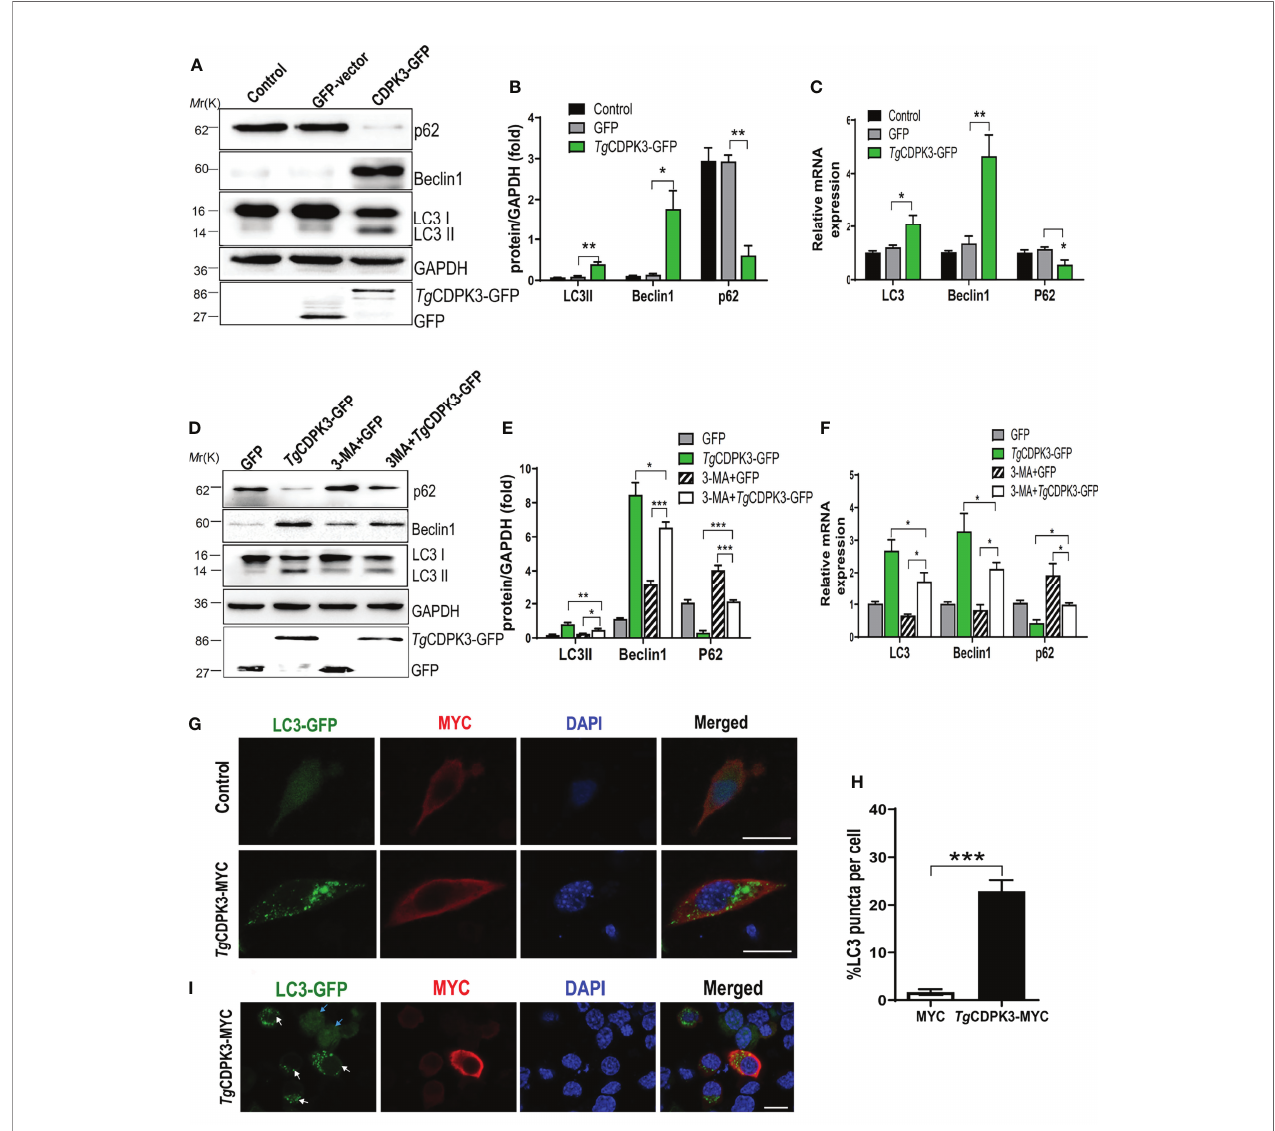
FIGURE 2 | Overexpression of Tg CDPK3 enhances autophagy activation. (A, B) Western blot analysis of LC3-II, Beclin-1, p62 in cells transfected with Tg CDPK3-GFP and control GFP-vector. GAPDH was used as a loading control. (C) RT-qPCR analysis of LC3, Beclin-1, p62 RNA levels in cells transfected with Tg CDPK3-GFP and control GFP-vector. GAPDH was used as a loading control. (D, E) Western blot analysis of autophagy proteins in different groups with pretreatment of a protease inhibitor 3-maleimidobenzoic acid (3-MA;5mM; Sigma-Aldrich, USA). GAPDH was used as a loading control. (F) Analysis of autophagic protein RNA levels in different groups with a protease inhibitor 3-MA. GAPDH was used as a loading control. (G) Immuno fl uorescence staining showed LC3 puncta increased signi fi cantly in cells transfected with Tg CDPK3-MYC. CDPK3-MYC (red), LC3-GFP (green), and DAPI (blue), (Scale bar:10 m m). (H) Data are mean ± SD of triplicates. Statistical differences are represented by ***p < 0.001, **p < 0.01, *p < 0.05 (n=3 each group). (I) Immuno fl uorescence staining showed LC3 puncta increased signi fi cantly in cells transfected with Tg CDPK3- MYC. CDPK3-MYC (red), LC3-GFP (green), and DAPI (blue). LC3-GFP puncta in Tg CDPK3-MYC transfected cells were noted with white arrows, and LC3-GFP in un- transfected cells were noted with blue arrows (Scale bar:10 m